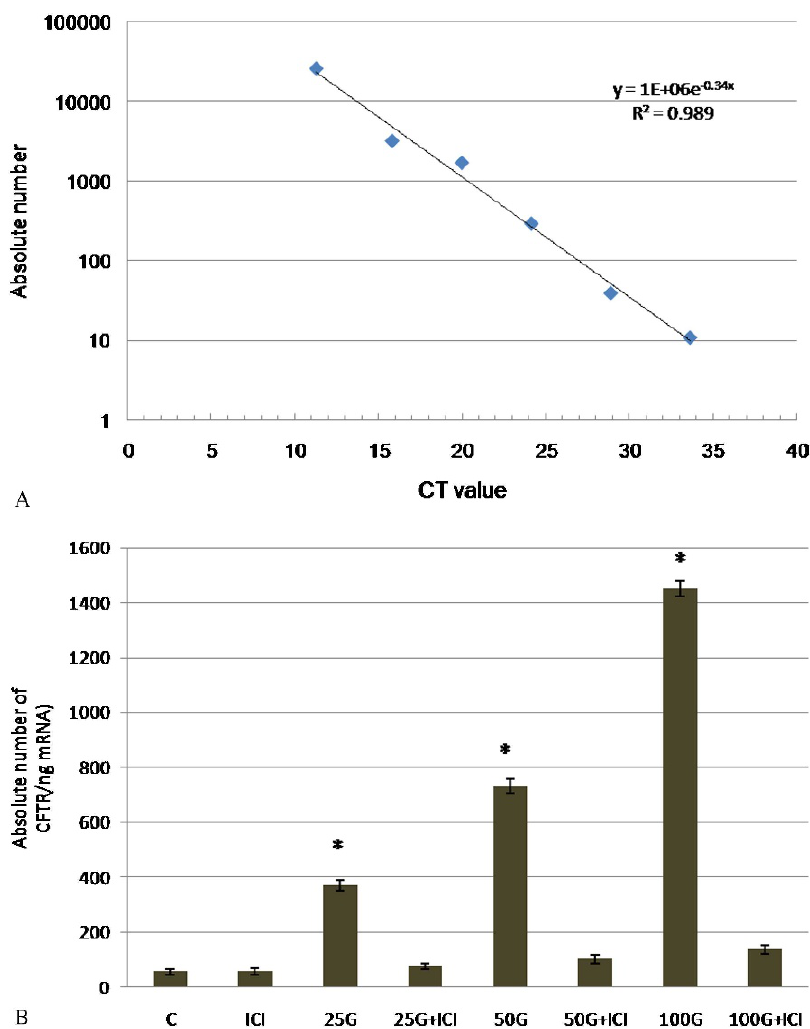
Figure 3 - (a) Standard curve obtained from cDNA dilution. The y axis represents the absolute nuclear DNA copy number, and the x axis represents the CT value. The linear regression equation was given by y=1E + 06e -0.34x , R 2 =0.989. (b) CFTR mRNA expression evaluated by real-time PCR. The absolute copy number (per 1 ng mRNA used for real-time PCR) was calculated from the standard curve (a). The expression of CFTR mRNA was 26 times higher following treatment with 100 mg/kg/day genistein compared with the control. The absolute copy number obtained from each sample represents the mean of four assays with the standard deviation. C = control, ICI = ICI 182780, 25G=25 mg/kg/day genistein, 25G (25 mg/kg/day genistein) + ICI 182780, 50G=50 mg/kg/day genistein, 50G (50 mg/kg/day genistein) + ICI 182780, 100G=100 mg/kg/day genistein, 100G (100 mg/kg/day genistein) +